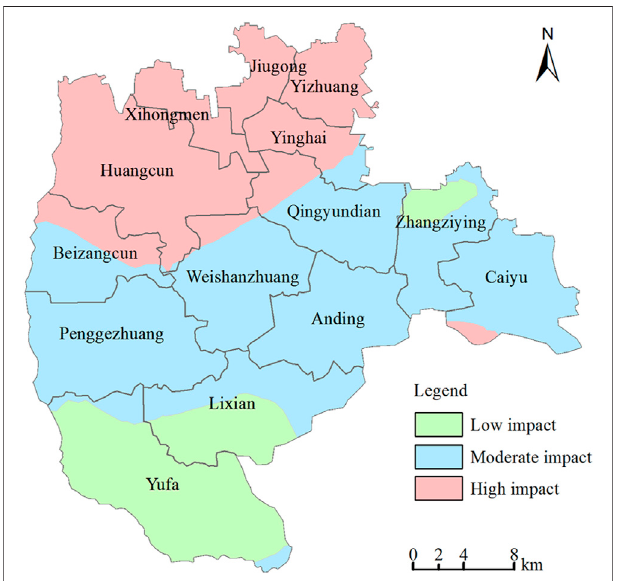
FIGURE 11 | Spatial distribution of the natural factors ’ in fl uence degree on the groundwater chemical composition.